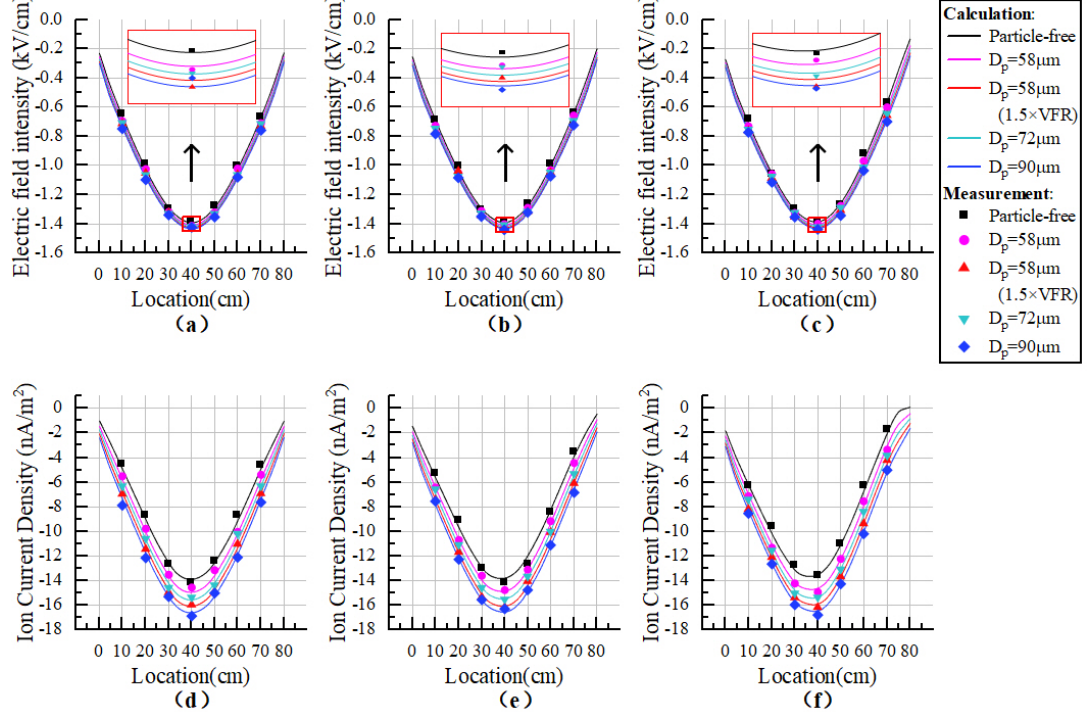
Figure 7. ( a – c ) Electric field intensity of 0, 5 and 10 m/s wind velocity; ( d – f ) ion current density of 0, 5 and 10 m/s wind